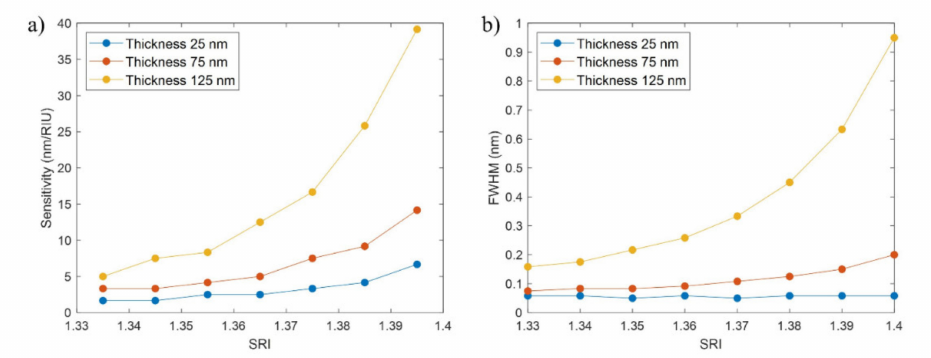
Figure 10. ( a ) Sensitivity to the SRI (nm/RIU) vs. SRI (RIU), and ( b ) FWHM (nm) vs. SRI (RIU), for a neck of − 2 µ m and thin-film thicknesses of 25, 75, and 125 nm.